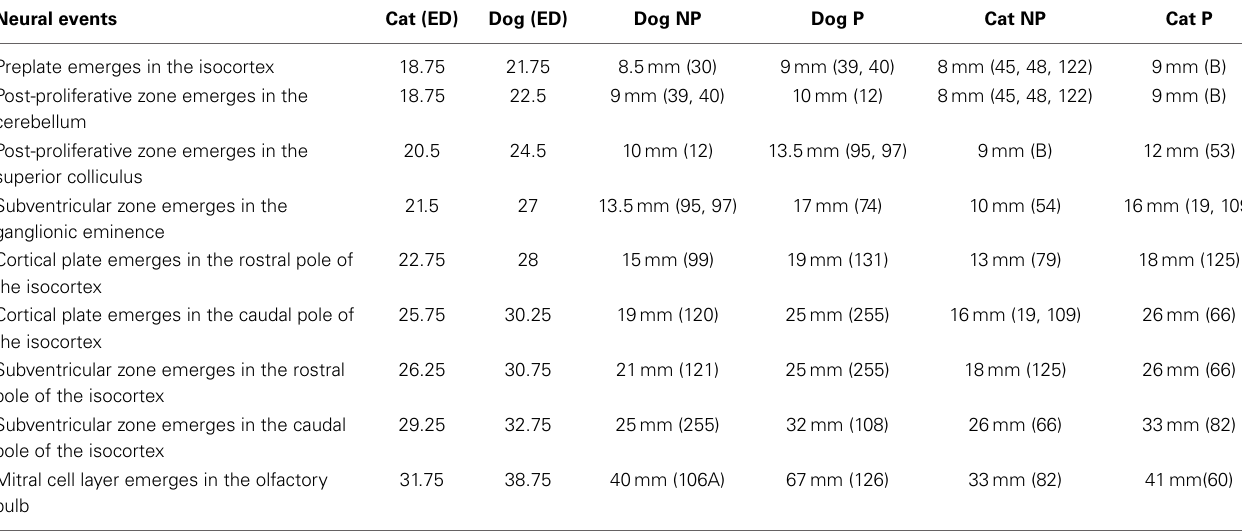
Table 1 | The timing of neural events in cats and dogs is expressed in embryonic days (ED) after conception.